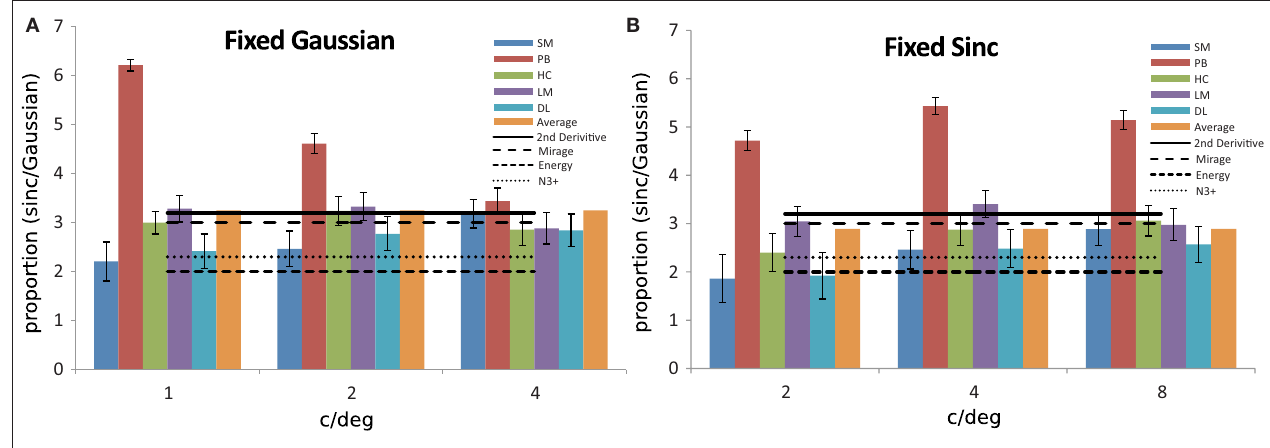
Figure 3 | Blur matches between gaussian- and Sinc-blurred edges for five observers, indicated by the caption. The y axis shows the ratio of λ / σ that produced an edge of matching blur when (A) the standard edge was Gaussian blurred with a fixed standard deviation of 1, 2, or 4 c/degree or (B) the standard edge was Sinc blurred with a standard deviation of 2, 4, or 8 c/degree. Error bars show ± 95% confidence